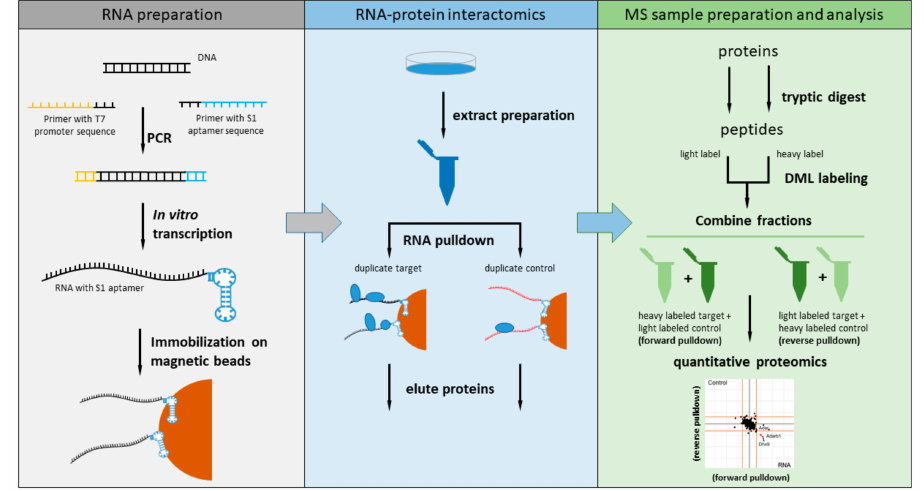
Figure 1. Schematic overview of our quantitative RNA-protein interaction screen of Malat1. RNA fragments of 500 bases length fused with the S1 biotin aptamer at their 3 (cid:48) -end were expressed in vitro, immobilized on paramagnetic streptavidin beads, and then incubated with nuclear enriched lysate. The bound proteins were analyzed by mass spectrometry-based quantitative